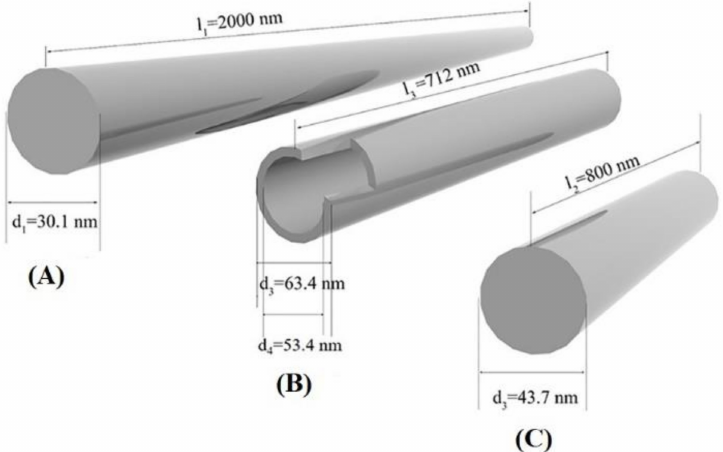
Figure 4. Spatial models for MnO 2 NWs ( A ), MnO 2 NTs ( B ), and MnO 2 NRs ( C